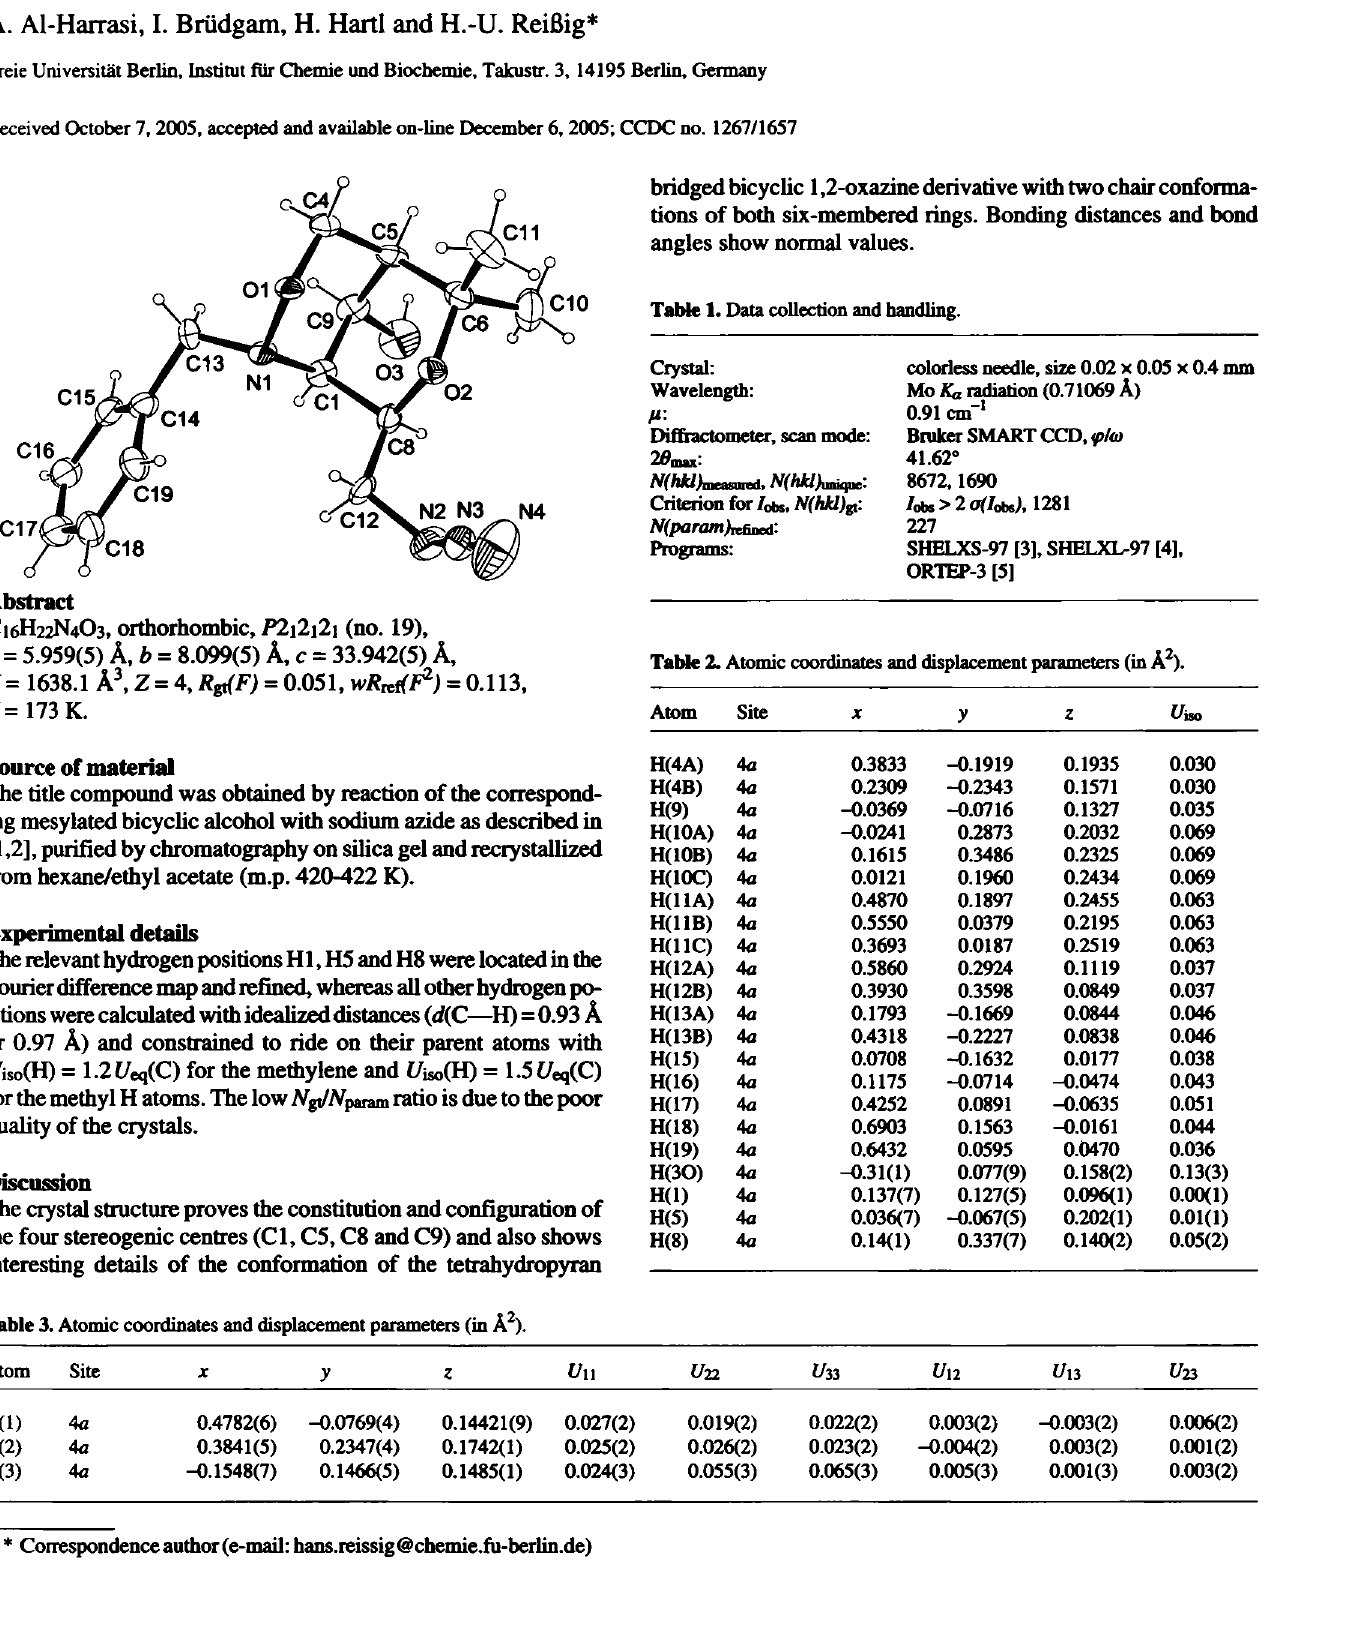
Table 1. Data collection and handling.